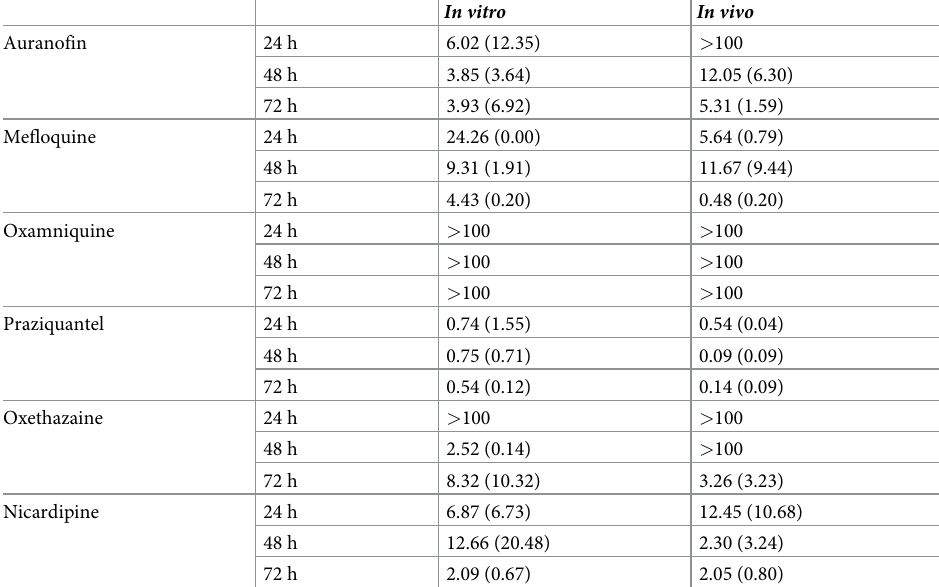
In vitro In vivo